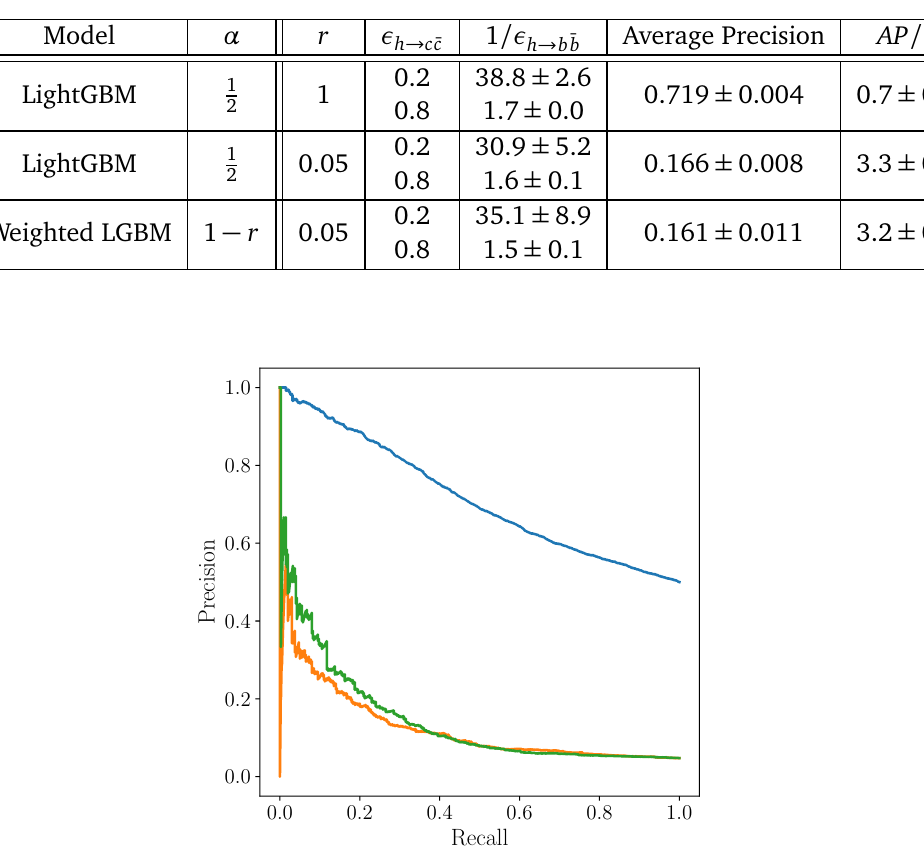
Table 2: The results of our three h → c ¯ c tagging tests. We report the back- = F PR , for two signal efficiency working points, ground rejection rate, ε h → b ¯ b